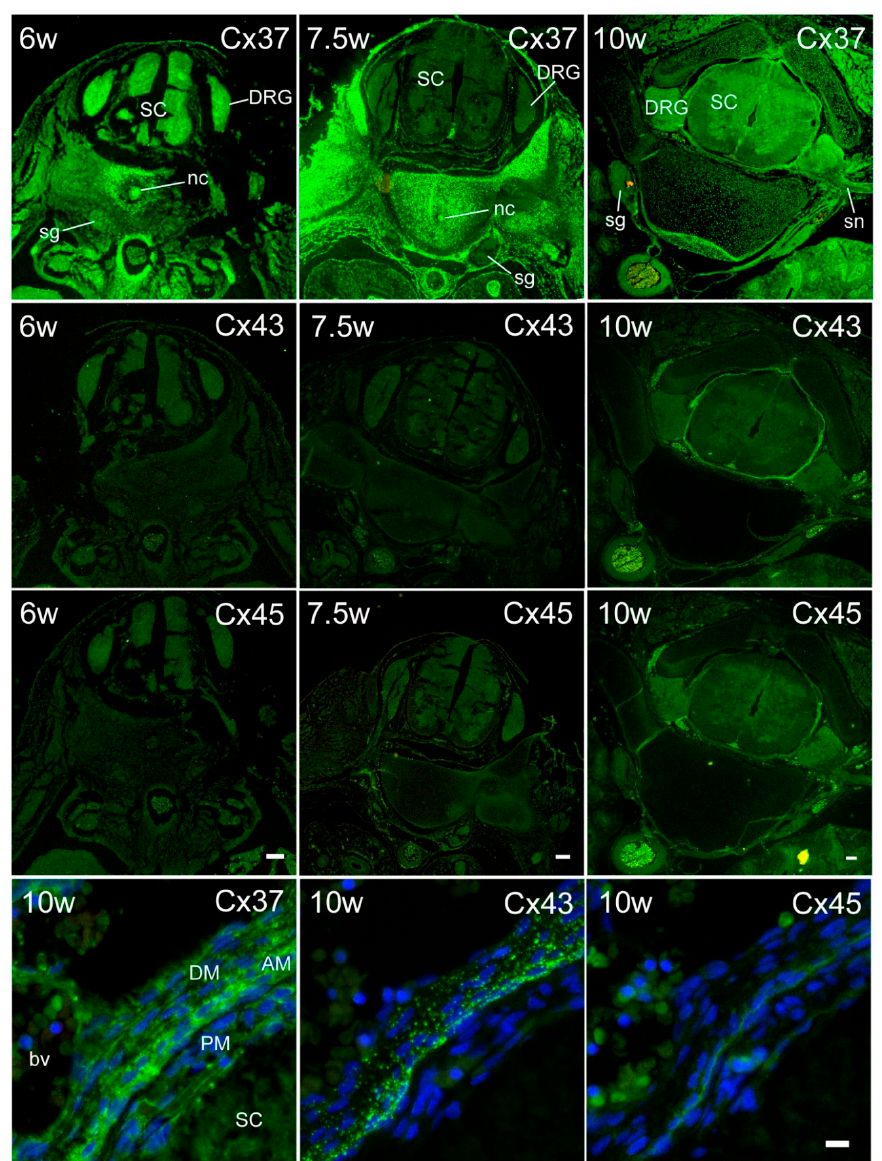
Figure 2. Expression of Cxs 37, 43, and 45 in the SC, ganglia, and meninges of human conceptuses. Thoracic segments of the SC of 6, 7.5, and 10 week-old human conceptuses were stained for Cx37, Cx43, and Cx45 (green). The strongest immunofluorescence was observed for Cx37 staining. SC—spinal cord; DRG—dorsal root ganglion; sg—sympathetic ganglion; sn—spinal nerve; nc—notochord. Objective magnification—4 × ; scale bars = 200 µ m. In addition to the neural tissues, substantial Cx immunoreactivity was also observed in meninges (the lowest row). DM—dura mater;